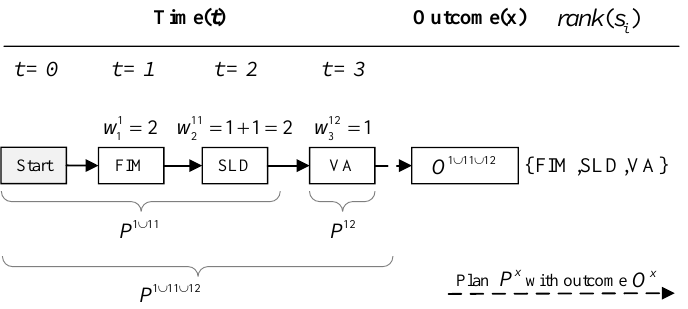
Figure 15. The third search tree after re-planning starting at time step t = 3 with the sub-plan P 12 and producing the final plan P 1 ∪ 11 ∪ 12 with the outcome O 1 ∪ 11 ∪ 12